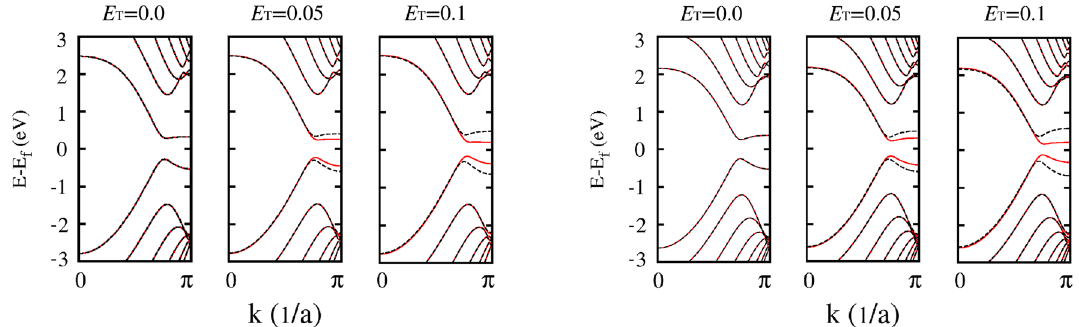
Figure 6. Band diagrams (at zero bias voltage) for the 6-zGNR (left) and the 8-zGNR (right) as a function of the transverse electric field, in units of of V / Å . The solid and dashed lines represent the spin-up and spin-down bands